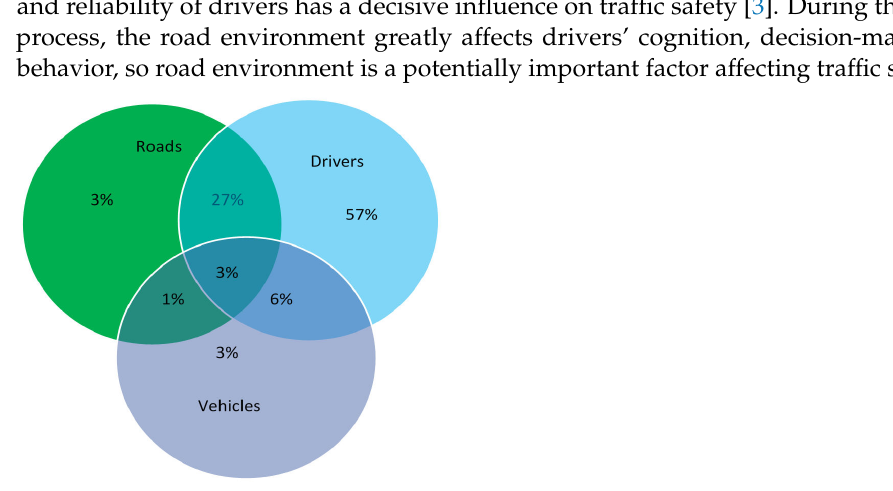
Figure 1. Causes of traffic accidents in